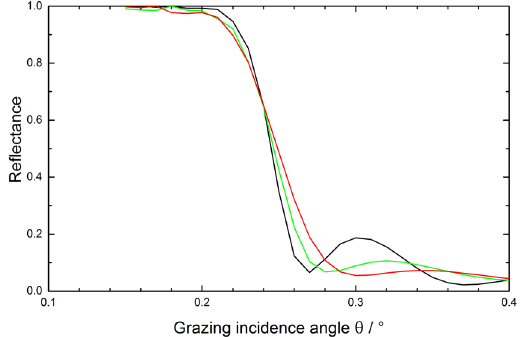
Figure 7. Comparison of XRR total reflection data at low grazing incidence angles for a pristine B 4 C-coated test mirror (black line) and after a-C coating plus subsequent H 2 /Ar plasma cleaning (green line: formerly a-C coated area; red line: non a-C coated area).